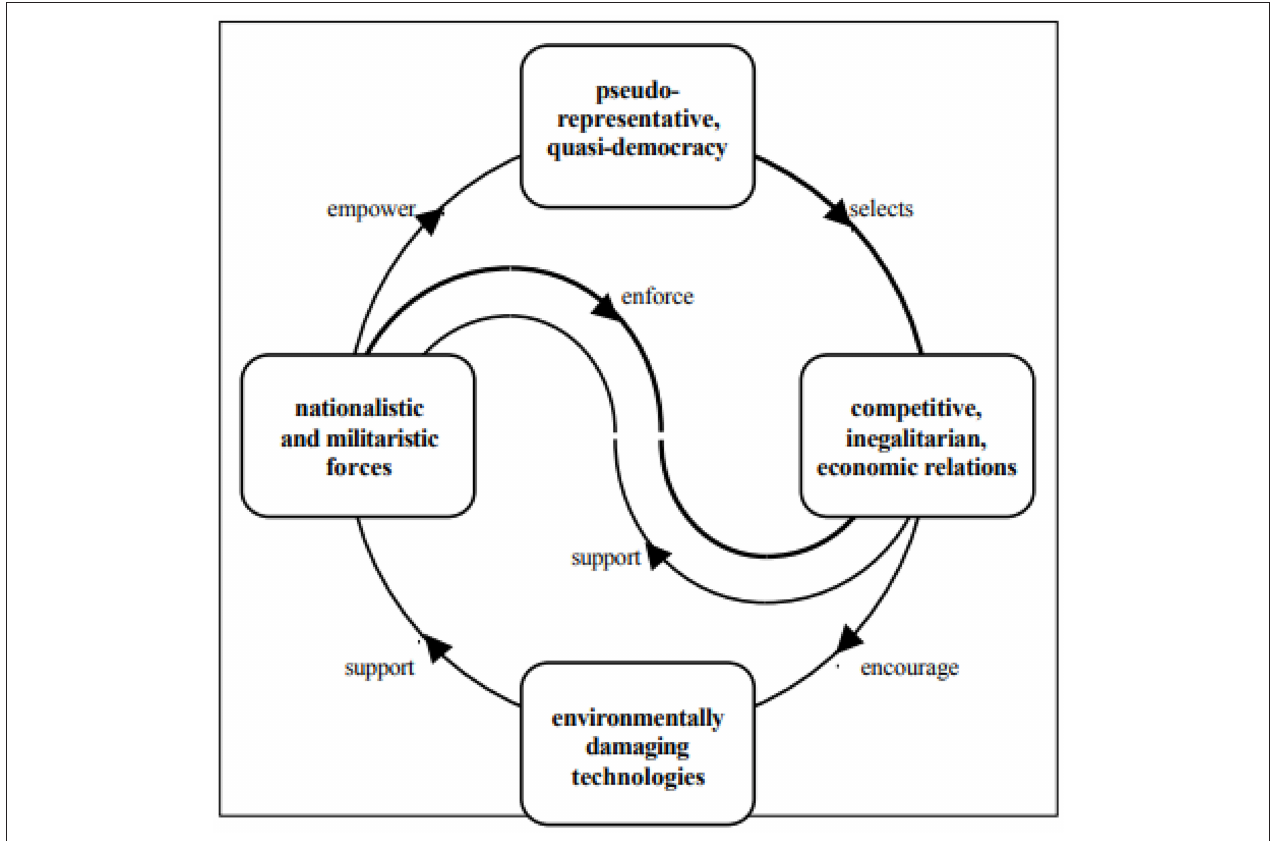
FIGURE 2 | Carter’s scheme of hazardous dynamics. Figure adopted from Carter (2004), p. 316 with kind permission of White Horse